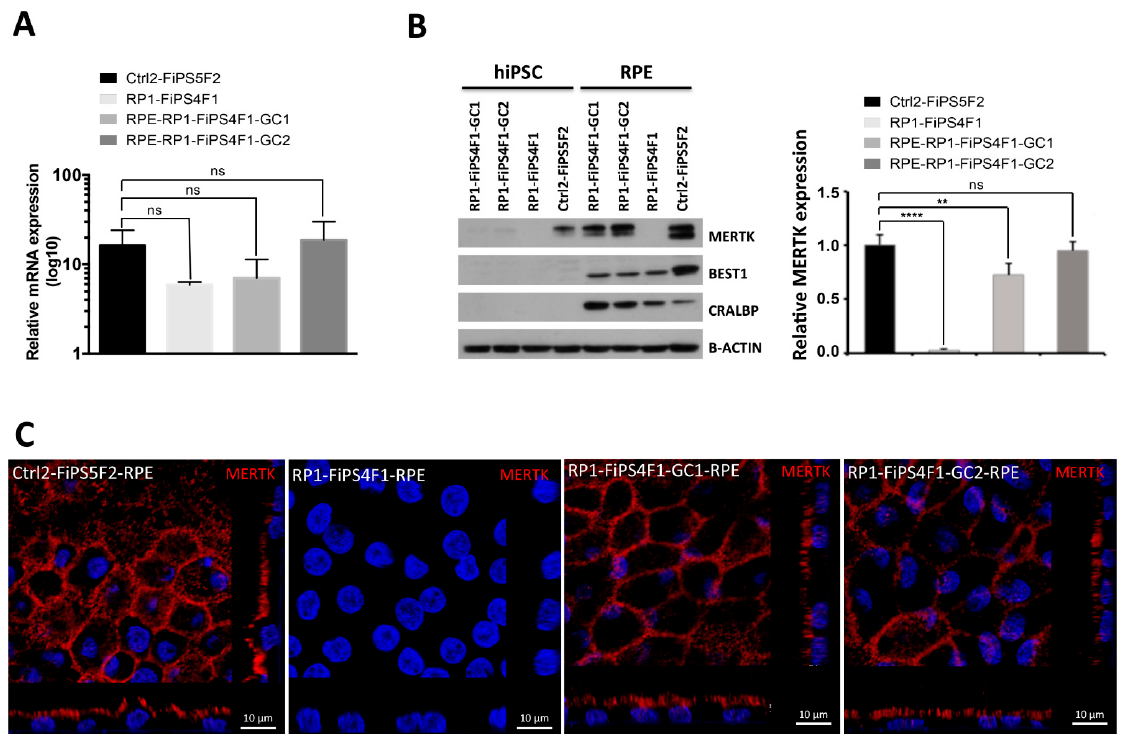
Figure 3. Recovery of Mer tyrosine kinase receptor (MERTK) expression in vitro. ( A ) qRT-PCR analysis of mRNA expression for MERTK. Data represent fold-change in mRNA expression of four hiPSC-RPE lines relative to their hiPSC. Each bar represents the average ± SEM of at least three independent biological replicates. The differences in mRNA expression between the control hiPSC-RPE with the uncorrected and corrected RP-hiPSC-RPE were tested for significance. ( B ) Western blot analysis of RPE-specific marker protein expression in hiPSC-RPE. The expression of CRALBP and BEST1 is detected in hiPSC-RPE, but not in the respective parental hiPSCs. MERTK expression is detected in corrected and control hiPSC-RPE but not in uncorrected RP-hiPSC-RPE. β -ACTIN used as loading control. The graph shows the relative quantification of MERTK expression representative of three different experiments of western blot. The differences in protein expression between the control hiPSC-RPE with the uncorrected and corrected RP-hiPSC-RPE were tested for significance (** p ≤ 0.01, **** p ≤ 0.0001) ( C ) MERTK expression in hiPSC-RPE. Confocal z-stacks micrographs show apical MERTK distribution in gene-corrected RP-hiPSC-RPE (RP1-FiPS4F1-GC1 and RP1-FiPS4F1-GC2) and healthy control hiPSC-RPE (Ctrl2-FiPS5F2). We failed to detect MERTK expression in uncorrected RP-hiPSC-RPE (RP1-FiPS4F1).